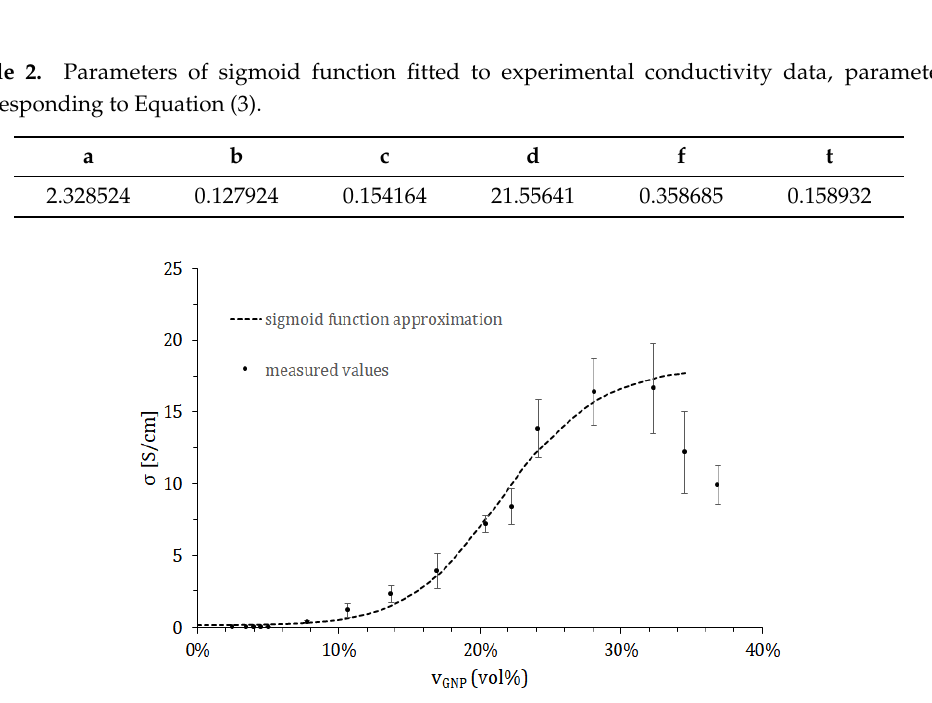
Figure 3. Electrical conductivity of silicone/graphene nanoplatelets composite depending on volumetric content of the graphene with fitted sigmoid function (Equation (3) and Table 2).